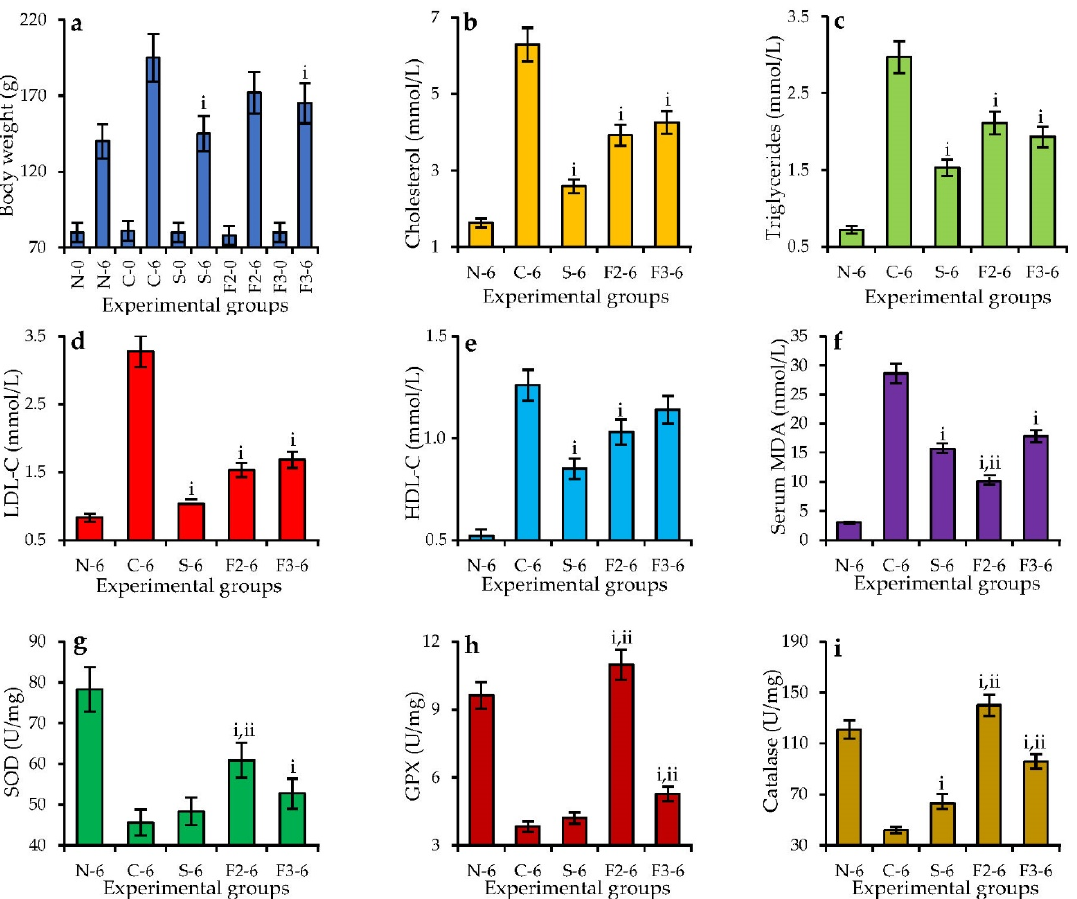
Figure 6. Changes in body weight ( a ), serum total cholesterol ( b ), serum total triglycerides ( c ), serum low-density lipoprotein–cholesterol (LDL–C) ( d ), serum high-density lipoprotein–cholesterol (HDL–C) ( e ), serum malondialdehyde level (MDA) ( f ), liver superoxide dismutase (SOD) ( g ), liver glutathione peroxidase (GPX) ( h ) and liver catalase ( i ) in hamsters with a normal diet (N), with a 1% cholesterol diet (C), with a 1% cholesterol diet + simvastatin (10 mg/kg/day; S), with a 1% cho- lesterol diet + DEAE–1% NaOH-f2 polysaccharide (250 mg/kg/day; F2), with a 1% cholesterol diet +